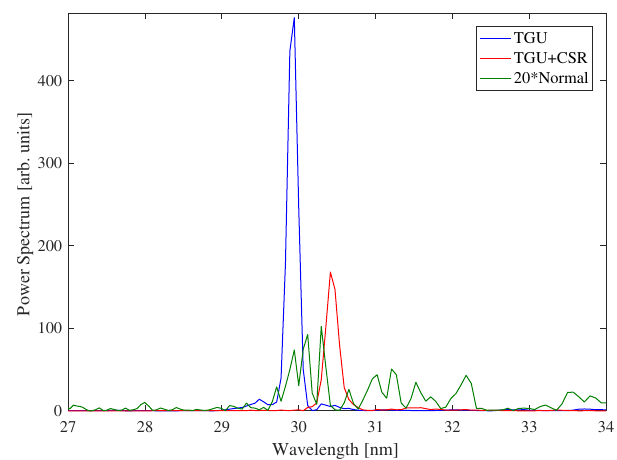
FIG. 8. Typical single-shot radiation spectrum of SASE FEL for the TGU cases and the normal undulator case through a 5 m